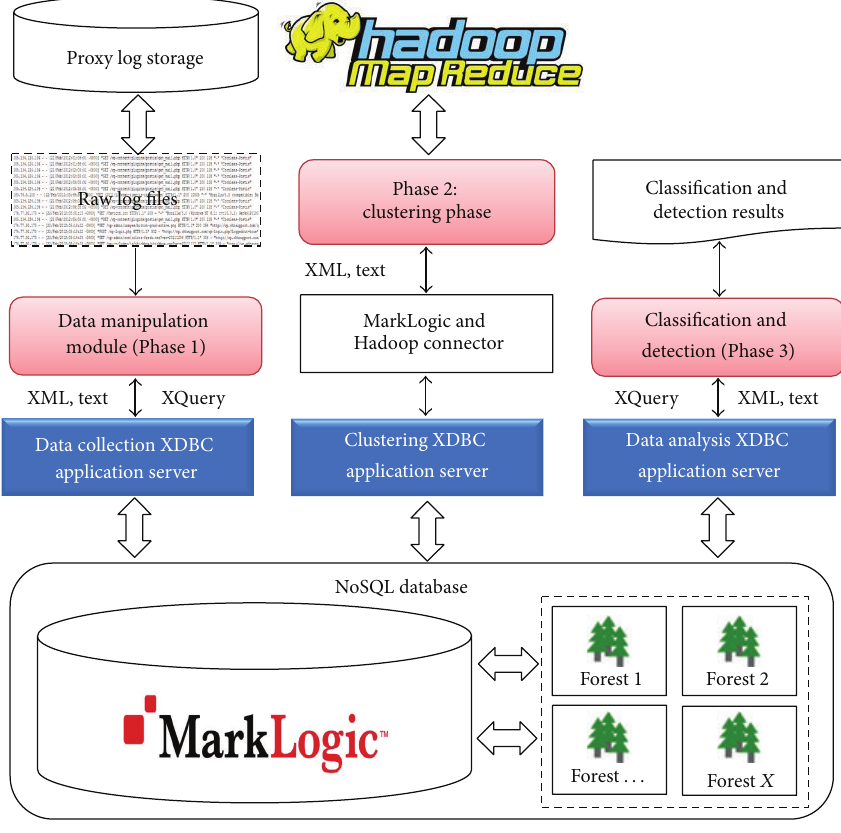
Figure 9: Big data based framework